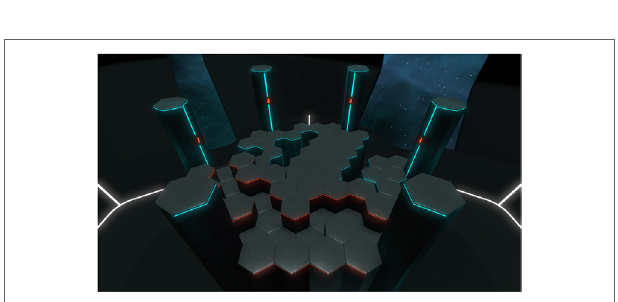
FigUre 5 | Configuration of the virtual arena during the first task: perception and deflection of projectiles.